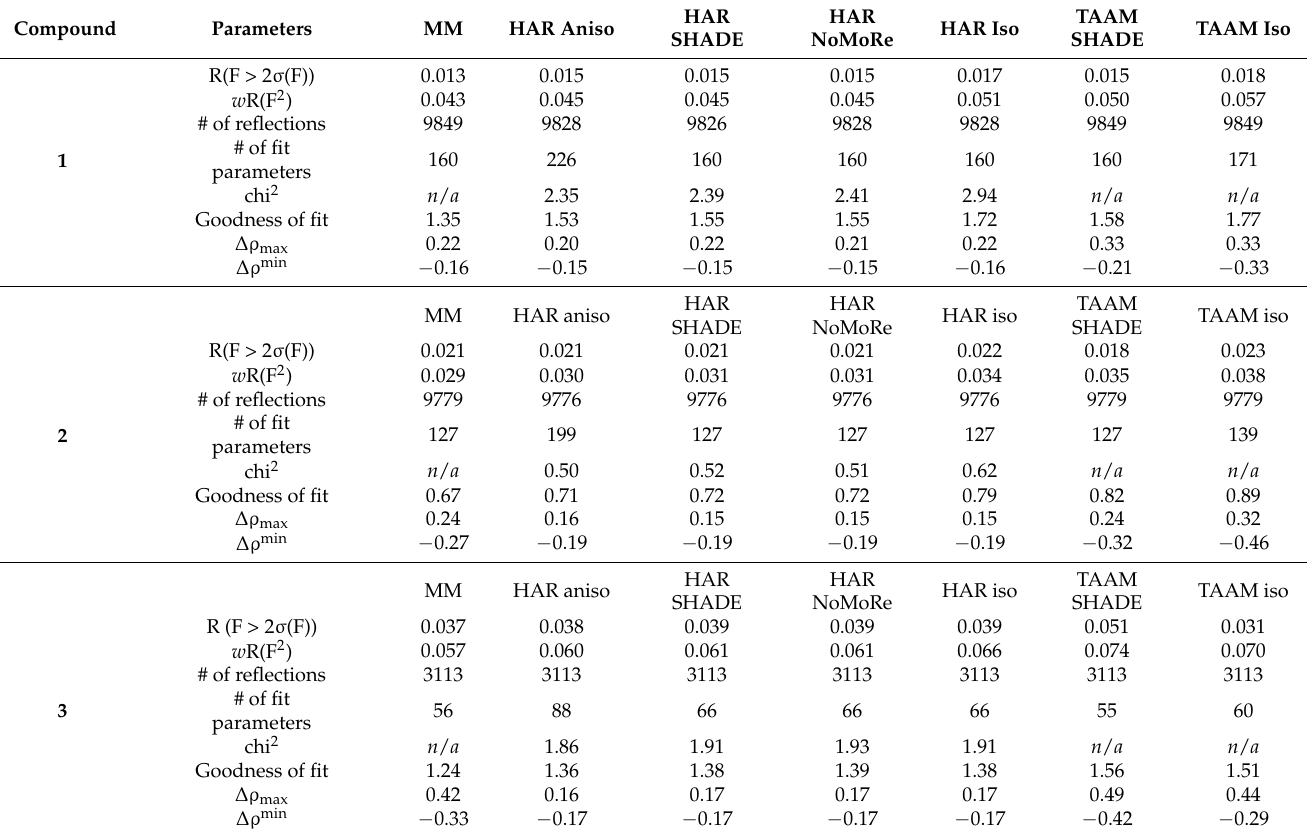
Table 1. Statistical parameters of MM, HAR, and TAAM refinements for 1 , 2 , and 3 against high-resolution Mo K α data.